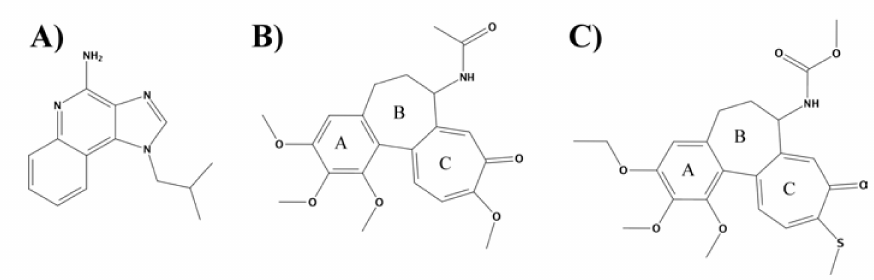
Figure 1. Chemical structure of A ) R-837, B ) colchicine and C ) CR42-24. For the latter two, the rings are named according to the convention used in the article (A, B,